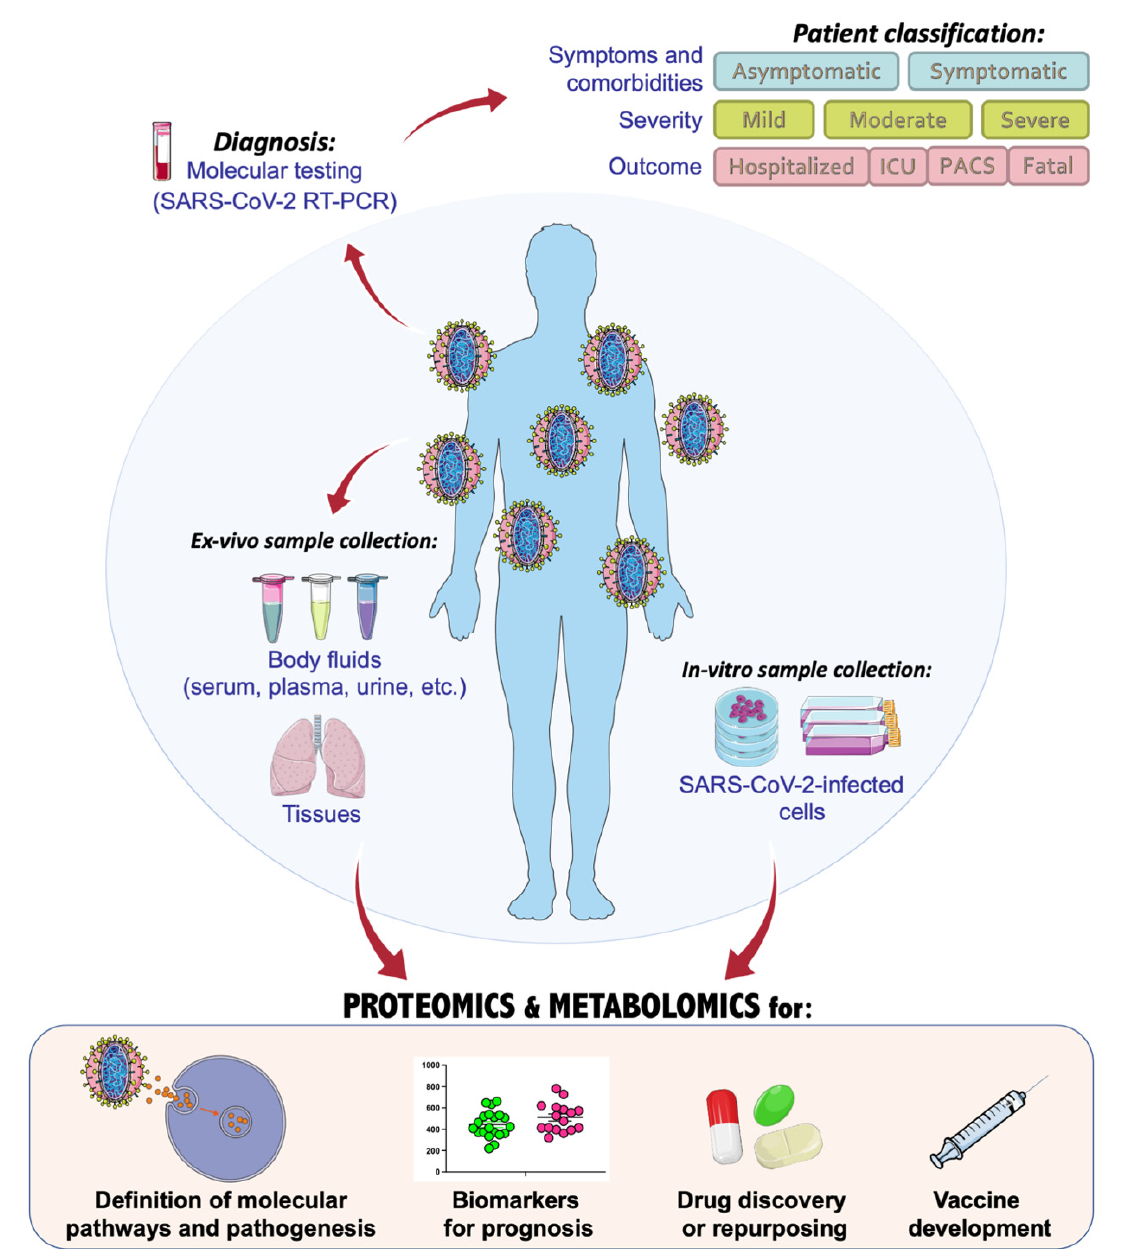
Figure 1. Application and integration of omics technologies to characterize the molecular biology of SARS-CoV-2 and COVID-19 pathogenic mechanisms and therapeutic approaches, with the main focus on proteomics and metabolomics investigations. This figure was drawn adapting the vector image from the Servier Medical Art bank (http://smart.servier.com/; last accessed 2 January 2022). COVID-19 = coronavirus disease 2019; SARS-CoV-2 = severe acute respiratory syndrome coronavirus 2; ICU = intensive care unit; PACS = post ‐ acute COVID syndrome.